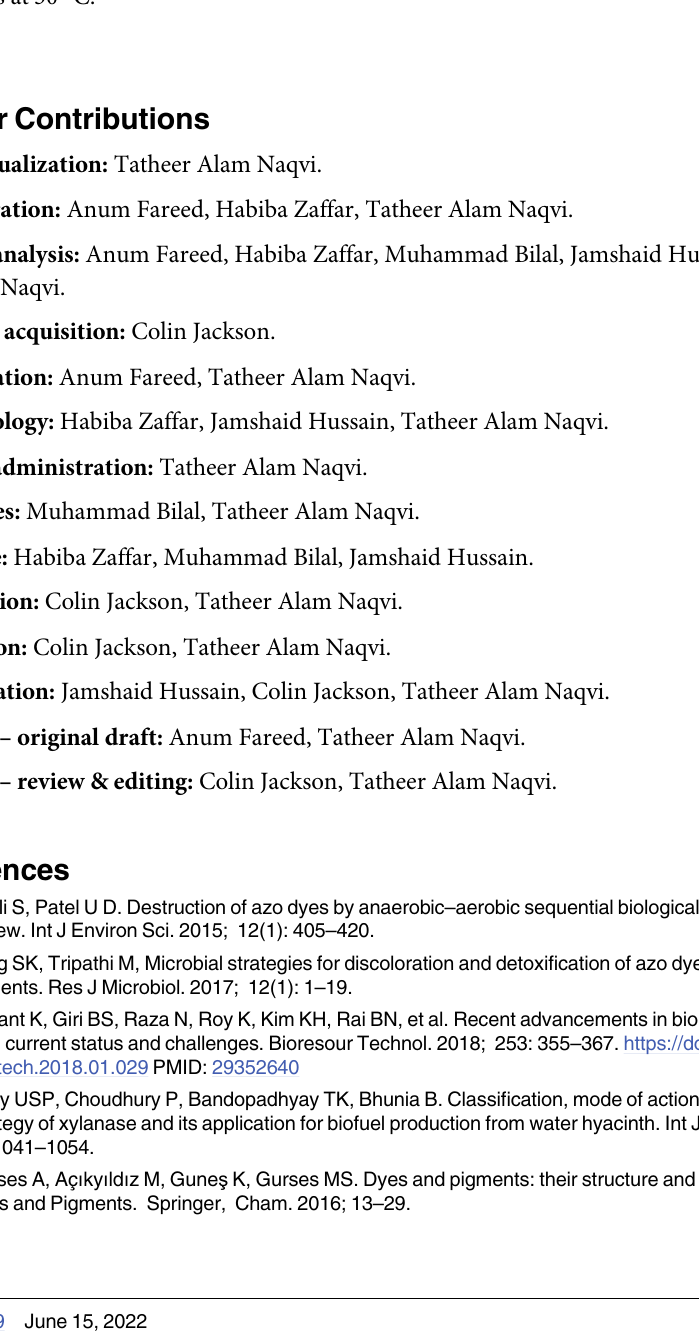
S2 Fig. Decolorization of Reactive black 5 by free and immobilized cells of bacterial strain (A) by free cells at 30 ˚C (B) by immobilized cells at 30 ˚C. S3 Fig. Concentrations of Reactive orange 16 degraded after treatment with free and immobi- lized cells of the bacterial strain (A) Degraded by free cells at 30 ˚C (B) Degraded by immobi- lized cells at 30 ˚C. S4 Fig. Concentrations of Reactive black 5 degraded after treatment with free and immobi- lized cells of the bacterial strain (A) Degraded by free cells at 30 ˚C (B) Degraded by immobi- lized cells at 30